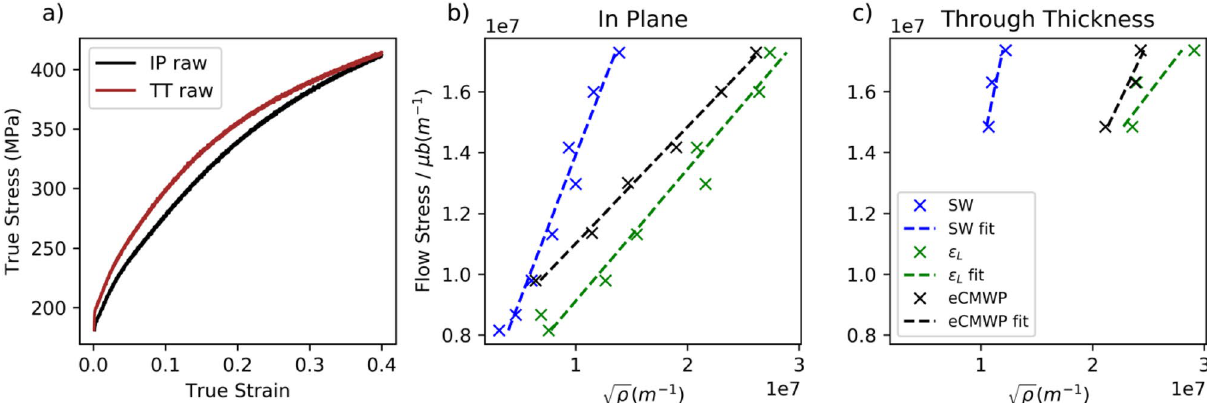
Figure 7. ( a ) Measured mechanical response of Ta during in plane and through thickness loading. Normalized Flow stress vs square root of the dislocation densities for samples loaded in plane ( b ) and through thickness ( c ). The dislocation densities extract by GPR-SW, GPR- ǫ L and eCMWP are shown in blue, green and black respectively. A linear fit is used to estimate the produce α M in Eq. (1). These fits are shown in dashed